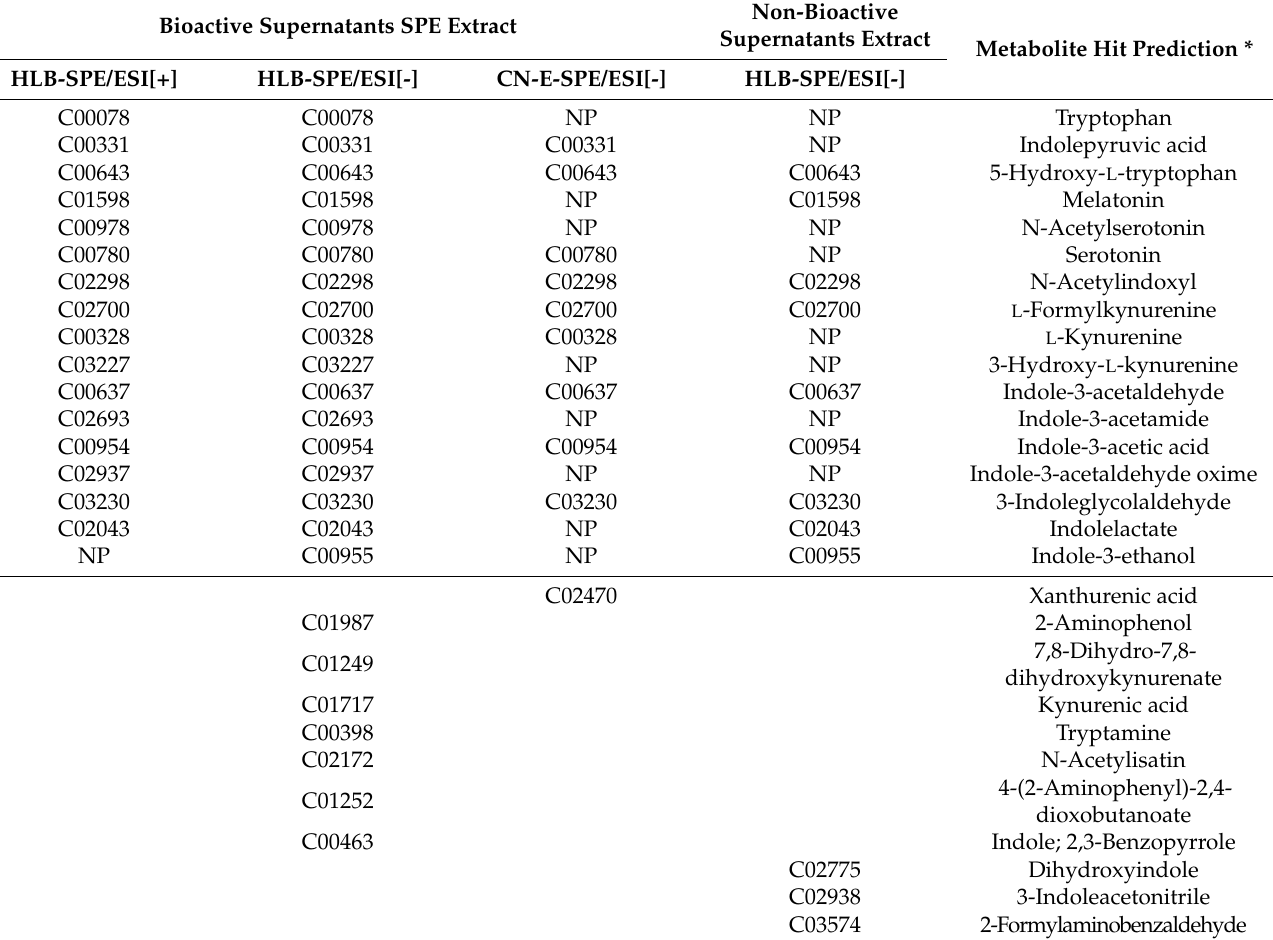
Table 3. Tryptophan metabolism pathway activity prediction (hits) directly from mass peaks of the most discriminant features (KEGG compound